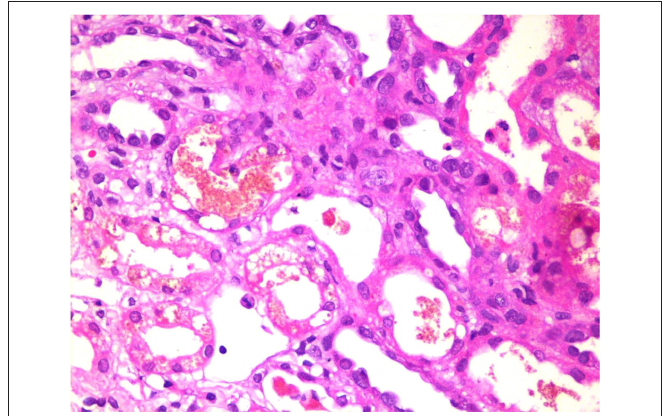
Figure 2. Fouchet stain showing positivity of bile pigments (Fouchet stain, × 400).